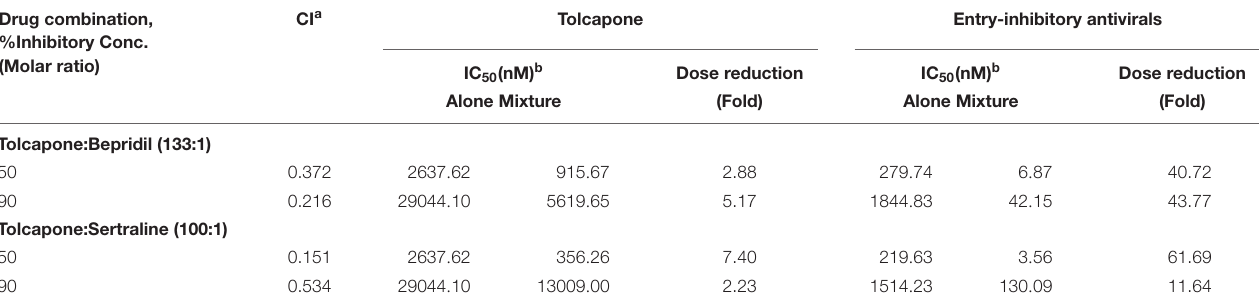
TABLE 2 | Combination index and dose reduction values for entry inhibition of Zaire-PsV infection by combining tolcapone with entry-inhibitory antivirals in semen. Drug combination, %Inhibitory